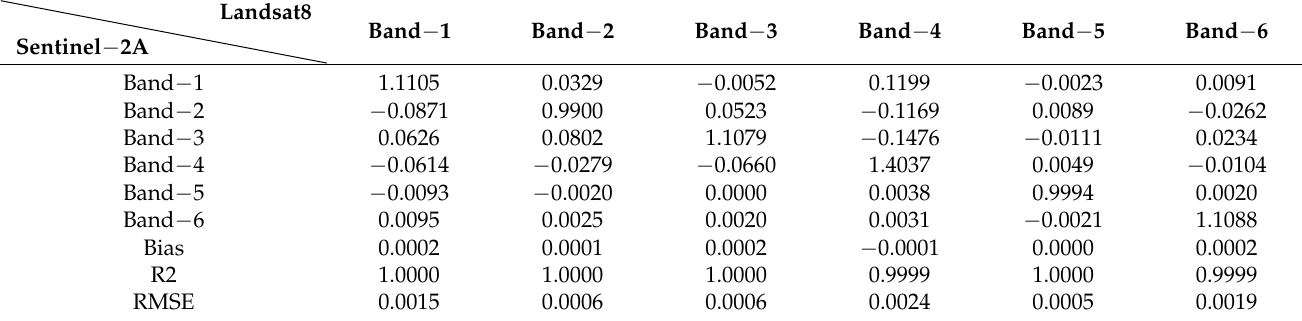
Figure 3. Normalization coefficient and errors by SpecLib − Single.